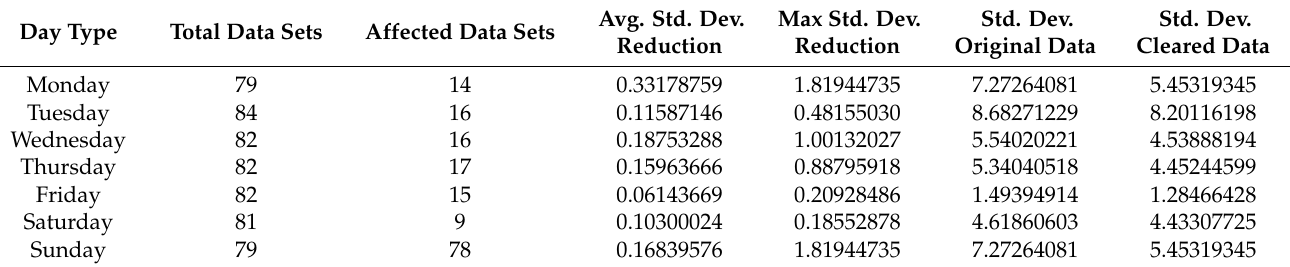
Table 14. Semester II baseline for original and cleared data sets.